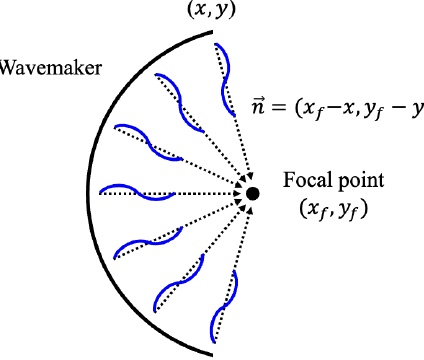
Figure 1. Bull’s -eye wave with directional focusing. Figure 1. Bull’s-eye wave with directional